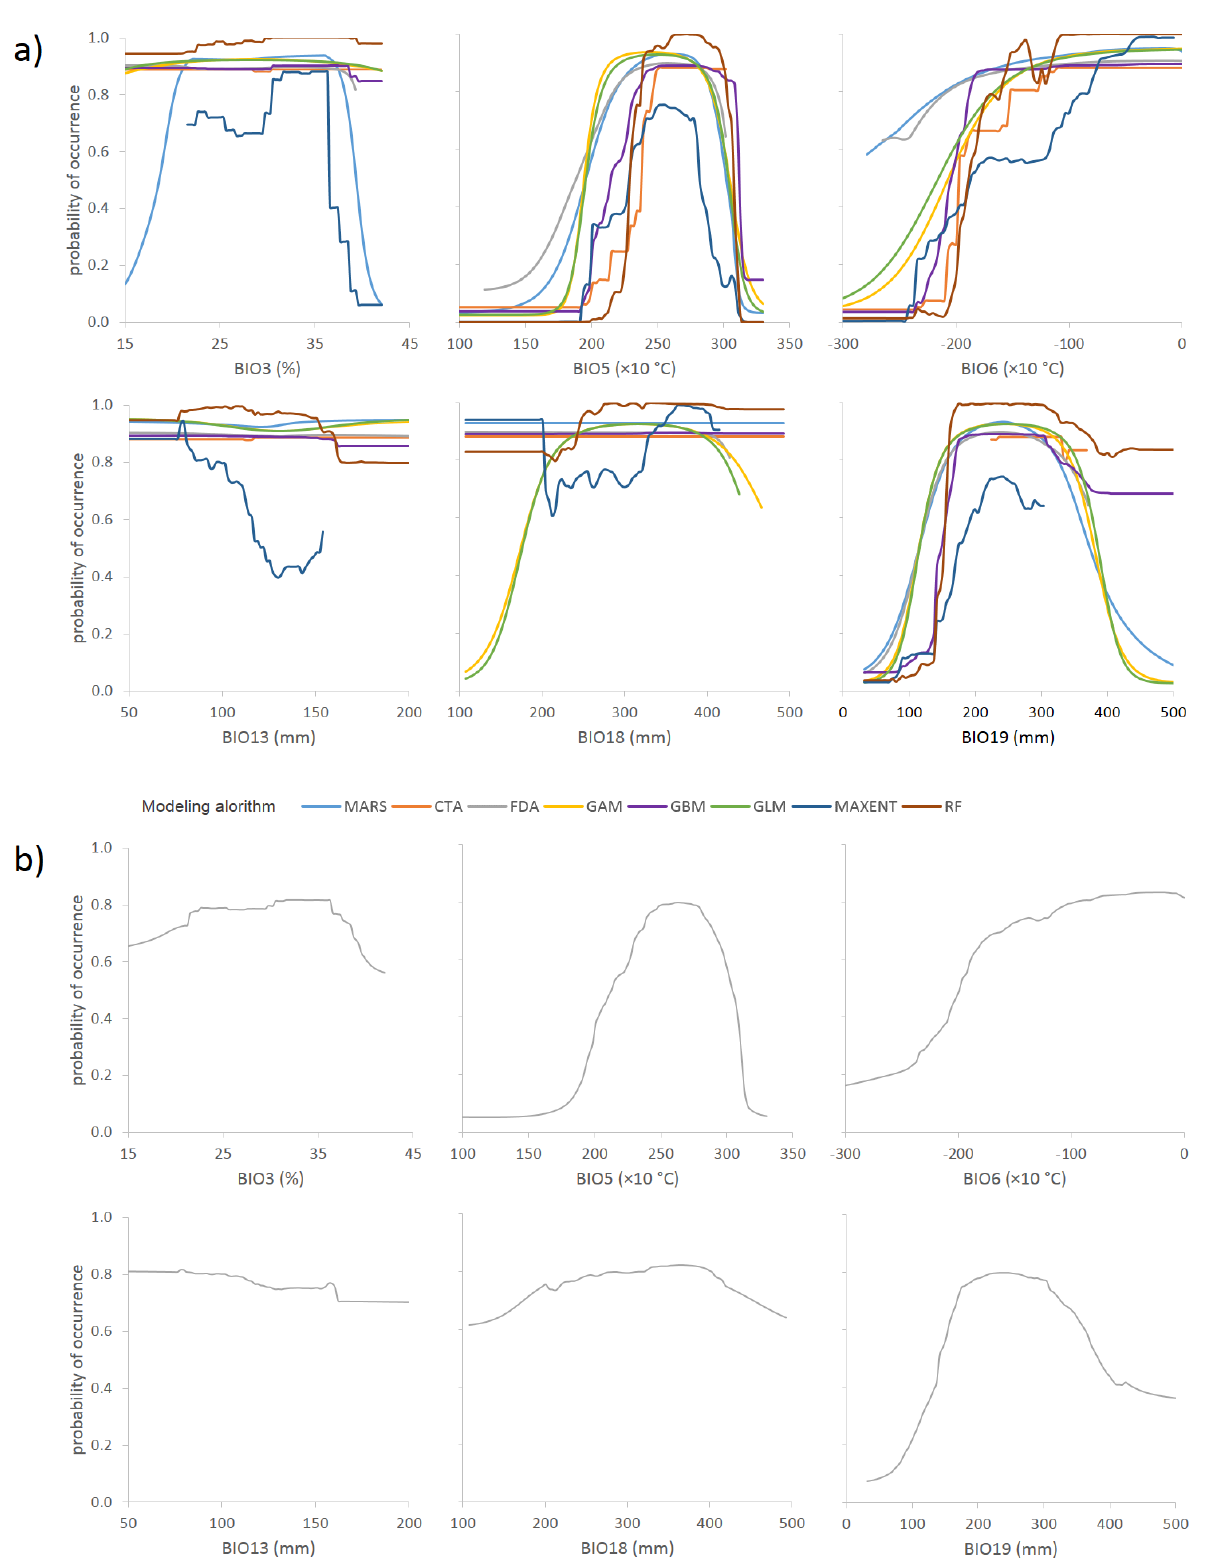
Figure 3. Response curves of the environmental variables for (a) the various modeling algorithms and (b) the consen- sus current model. Environmental variables are described in Table